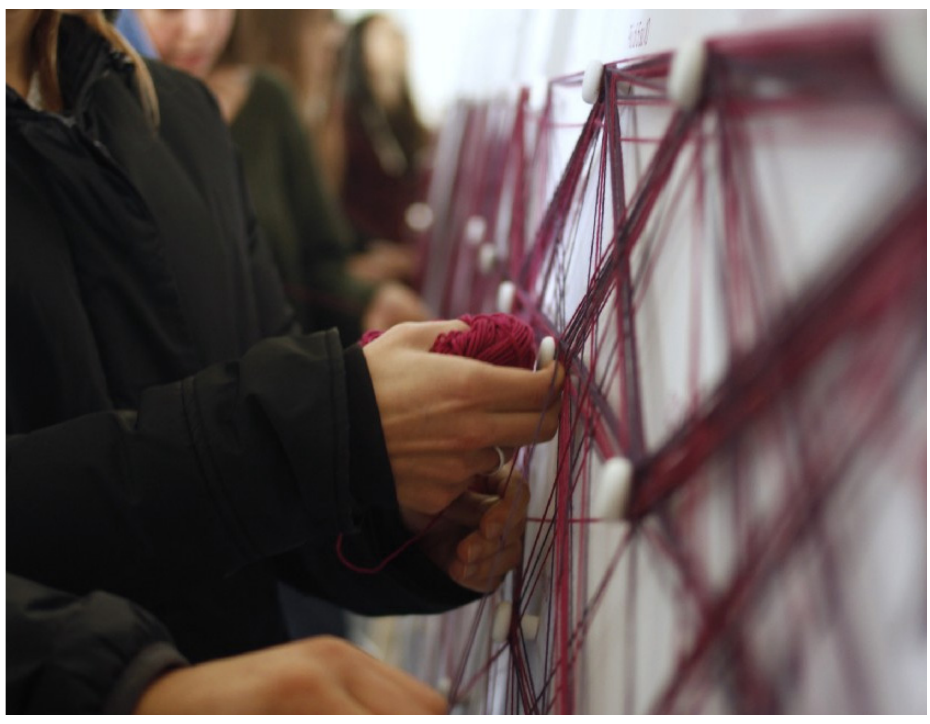
KNOW AND BE LIVE: A PARTICIPATORY PHYSICAL SOCIO-DESIGN ARTEFACT Detail from the TedMed